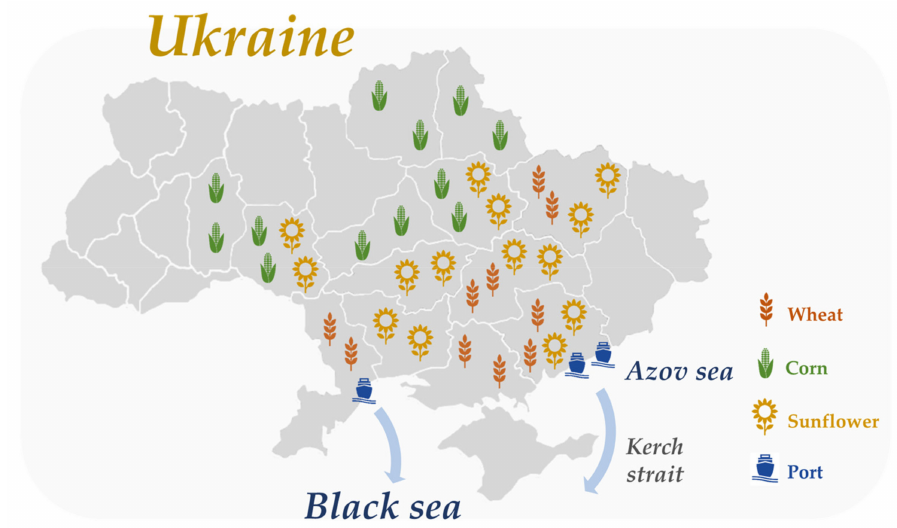
Figure 4. Main regional production areas of wheat, maize, and sunflower, ports at Azov and Black Seas, and maritime routes for Ukrainian agricultural production. Information adapted from International Grains Council